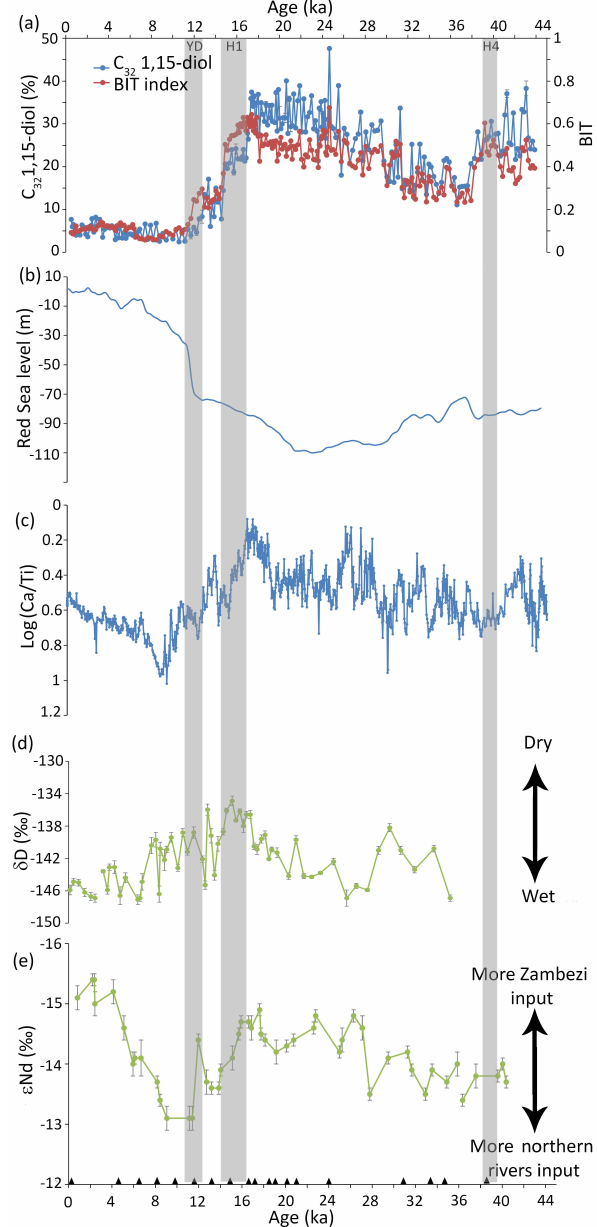
Figure 2. Organic and lithologic proxy records for core 64PE304- 80 and parallel core GIK16160-3. (a) BIT index indicating soil and riverine input (Kasper et al., 2015) and F C321 , 15 tracing riverine in- put; (b) Red Sea level changes (Grant et al., 2013); (c) log(Ca / Ti) indicating terrestrial input (van der Lubbe et al., 2014); (d) recon- struction of δ D precipitation based on leaf wax n -C 29 alkane of core GIK16160-3 (Wang et al., 2013), and (e) ε Nd signatures of the clay fraction document changes in riverine influence (van der Lubbe et al., 2016). The grey bars show the YD, H1, and Heinrich Event 4 (H4). Black triangles indicate positions where 14 C AMS dates were obtained (Kasper et al.,